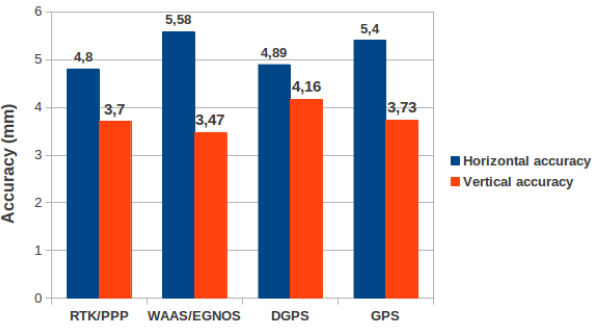
Figure 8: Accuracy of different GPS receivers using